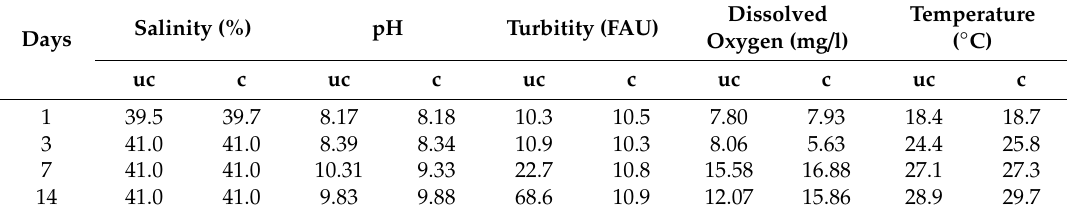
Table 1. Measured physicochemical parameters in the tanks with the uncoated (uc) and coated (c) nets.